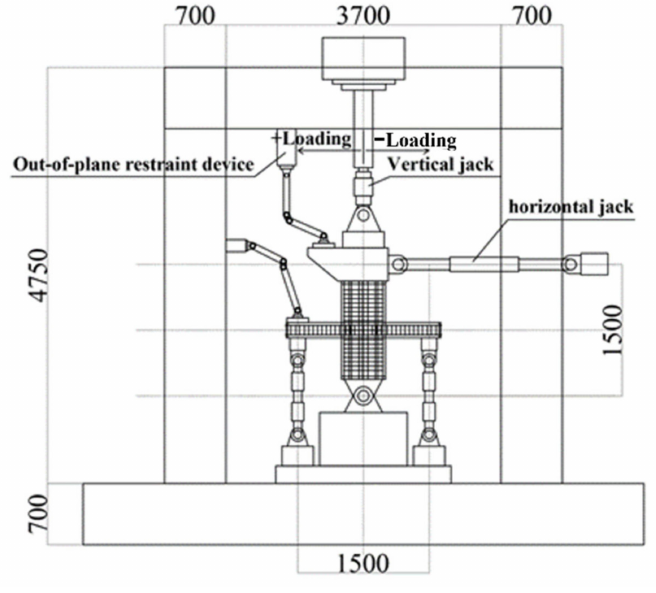
Figure 10. Loading arrangement [6,7].